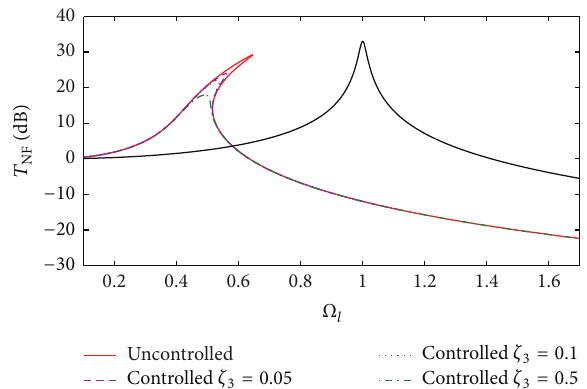
Figure 16: Force transmissibility of the controlled system under ̂𝜆 = 0.4 ). different feedback gain 𝜁 3 without time delay ( 𝜁 1 = 0.025 , 𝑓 1 = 0.05 , 𝑘 = 1 , and ̂𝜆 = 0.4